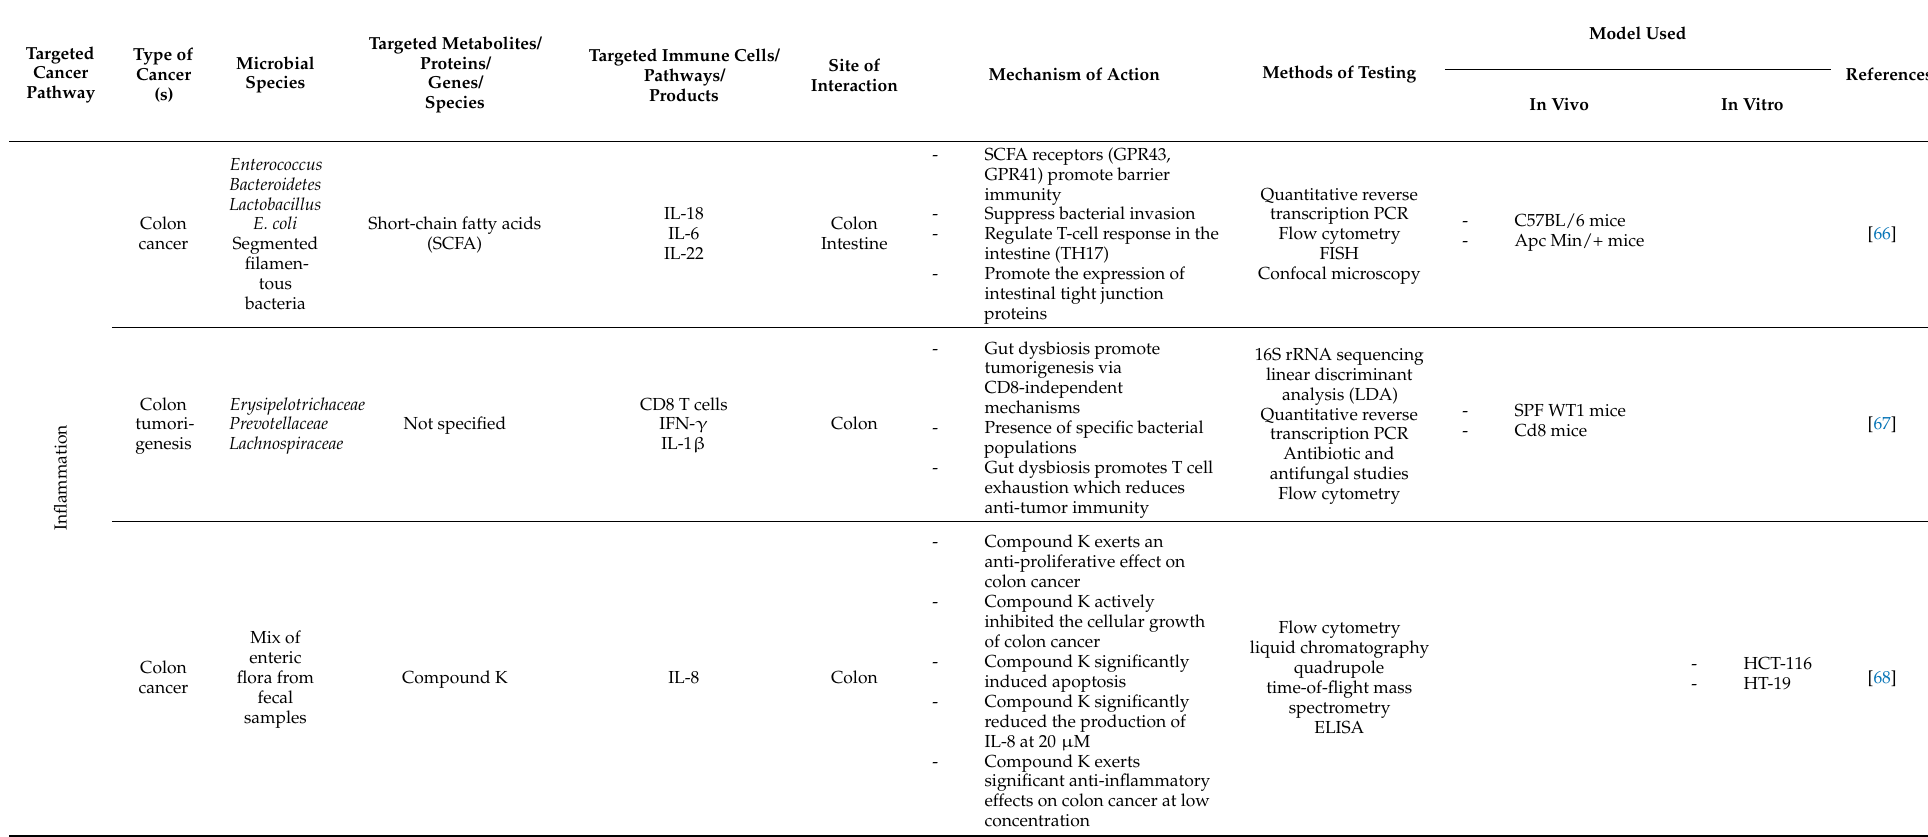
Table 1. Representative microbial–immune interactions and their underlying anticancer